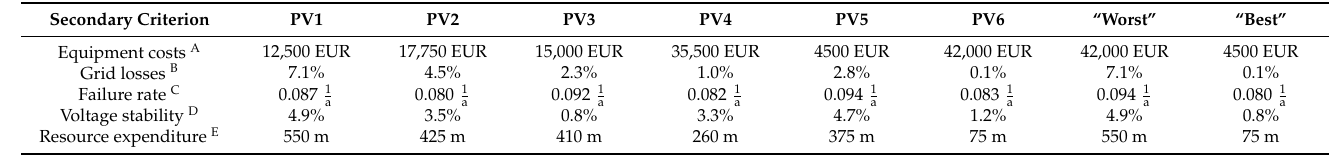
Table 8. Exemplary input parameters of six planning variants (PV) for the secondary assessment